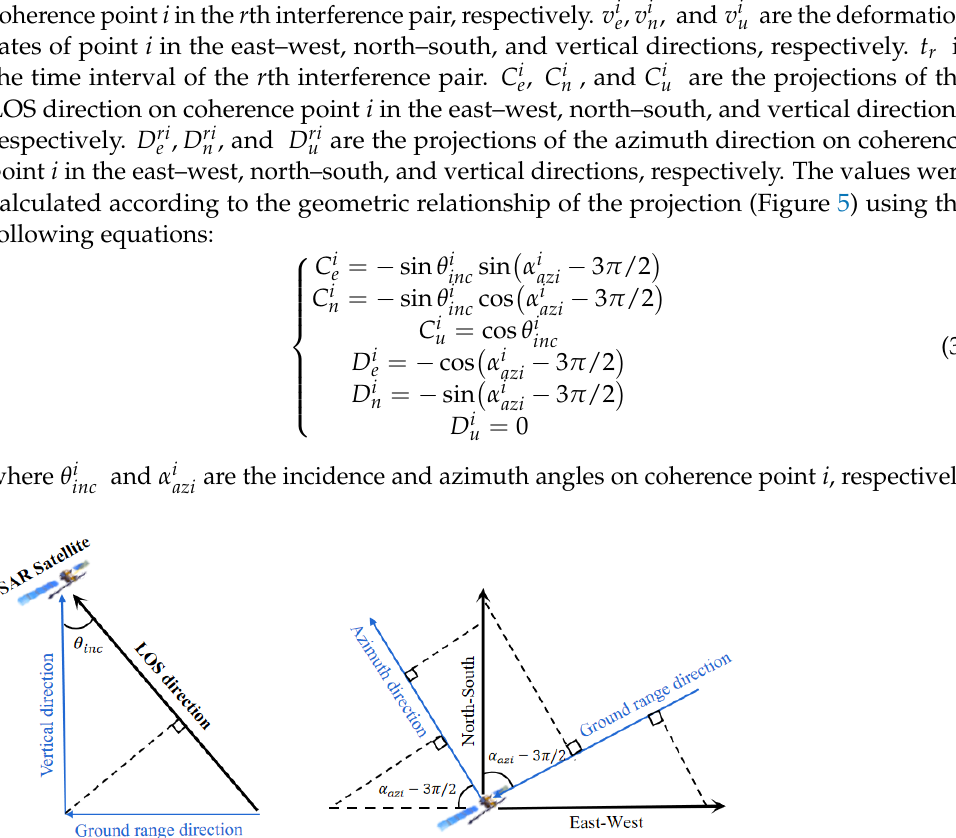
Figure 5. Geometric relation of ascending SAR image (arrow direction is positive).